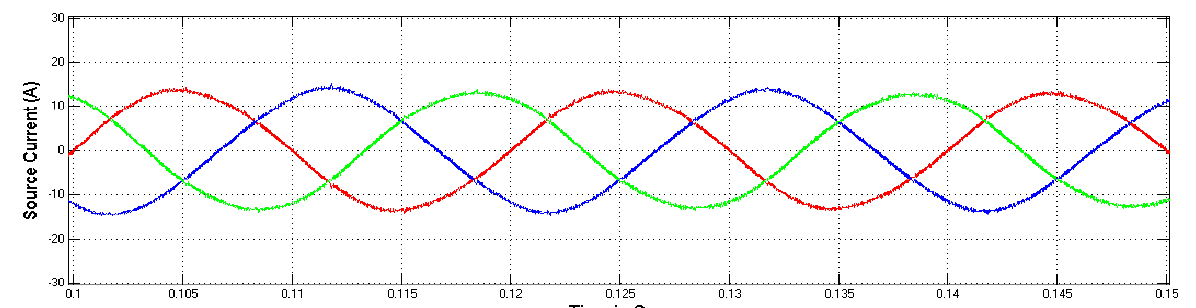
Figure 16. Source Voltage